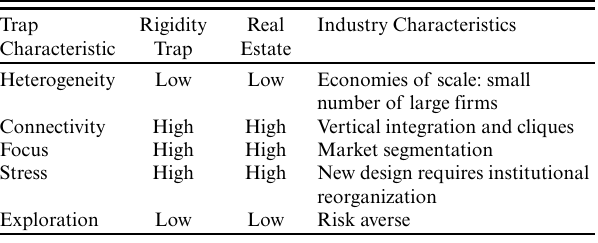
Table 2 . Evidence of a rigidity trap in the real estate